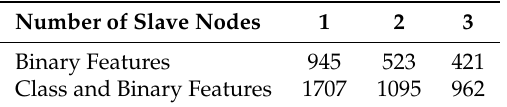
Table 8. Running time per slave nodes (in seconds) for MapReduce implementation.